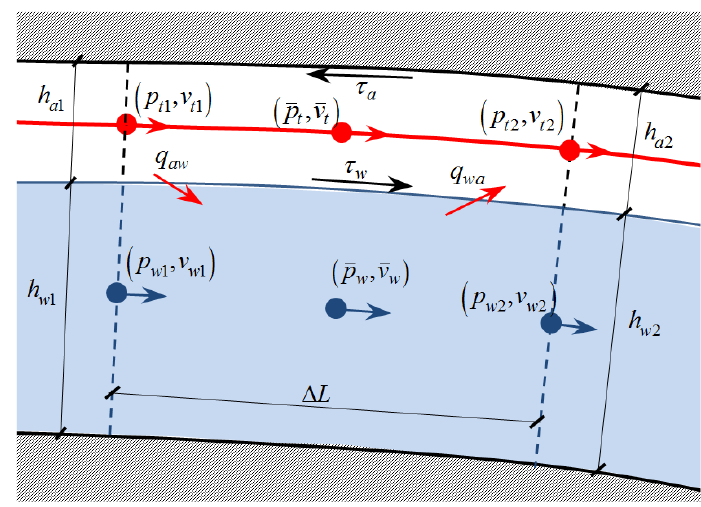
Figure 3. Airflow analysis of the gradually varied section.